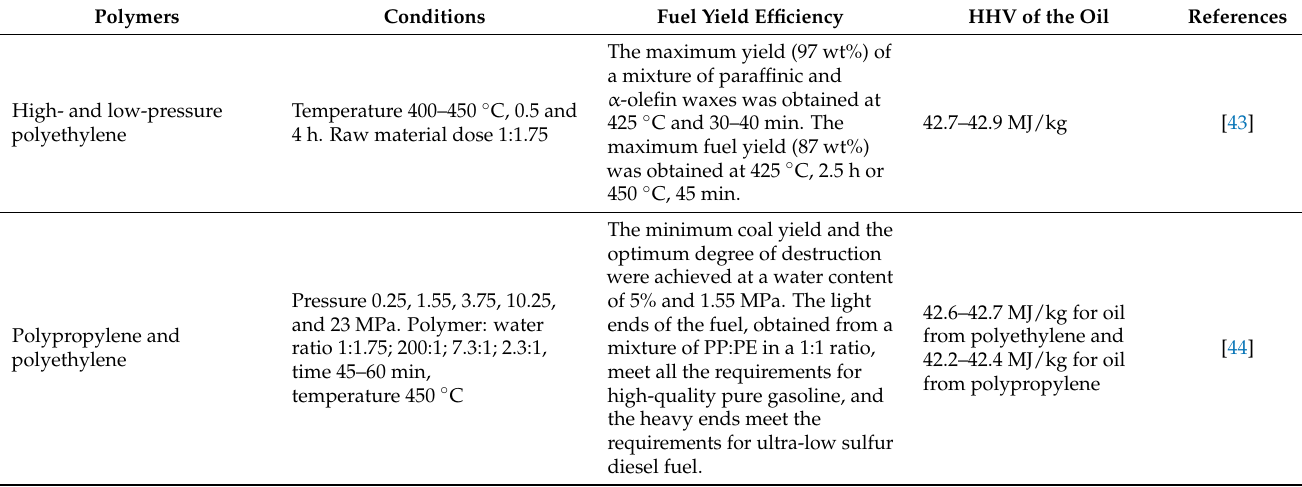
Table 3. Overview of polymer processing